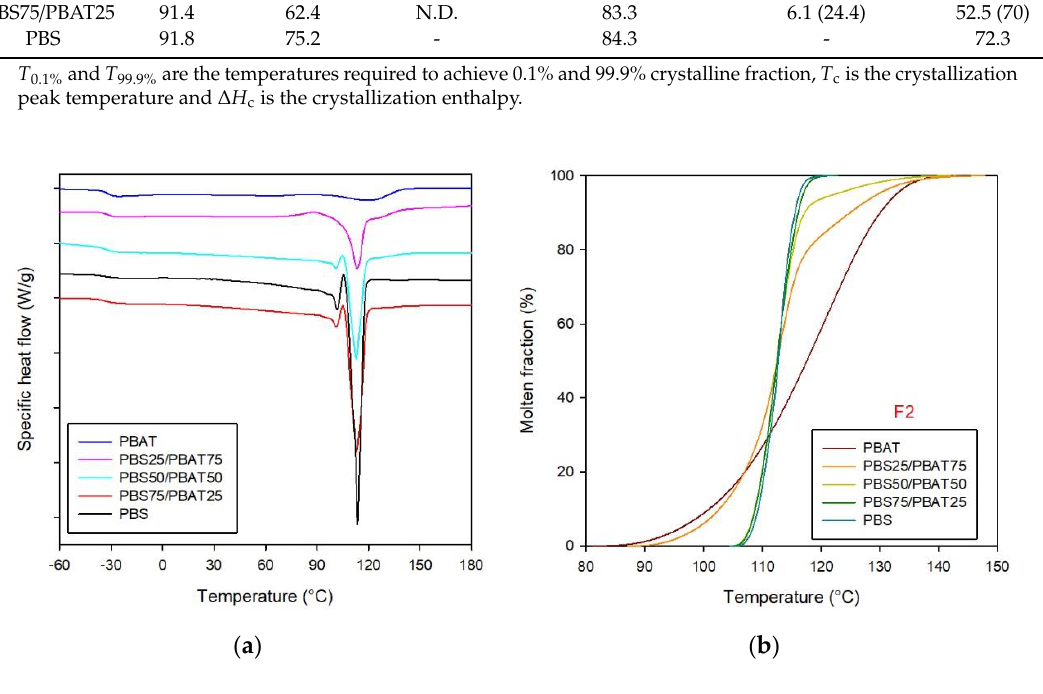
Figure 4. DSC thermograms of PBS, PBAT and their blends: ( a ) second heating run, ( b ) molten fraction vs. temperature.